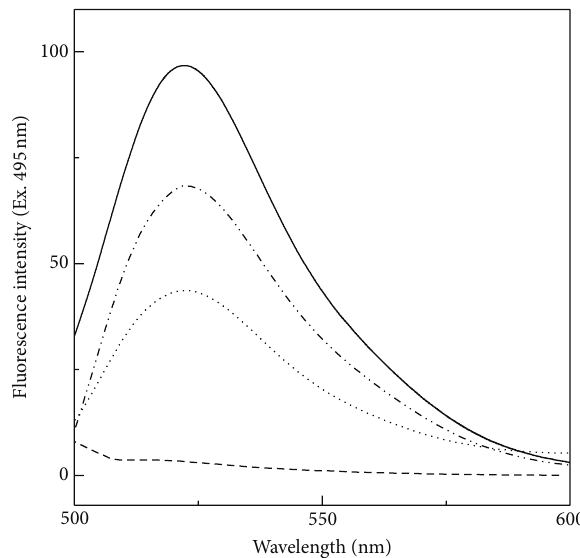
Figure2:Fluorescencespectraof0.50 𝜇 MFITC-BSAintheabsence and presence of increasing urea concentrations upon excitation at 495 nm. The urea concentrations ( 1 → 40 ) were 0, 0.5, 1.0, 1.5,